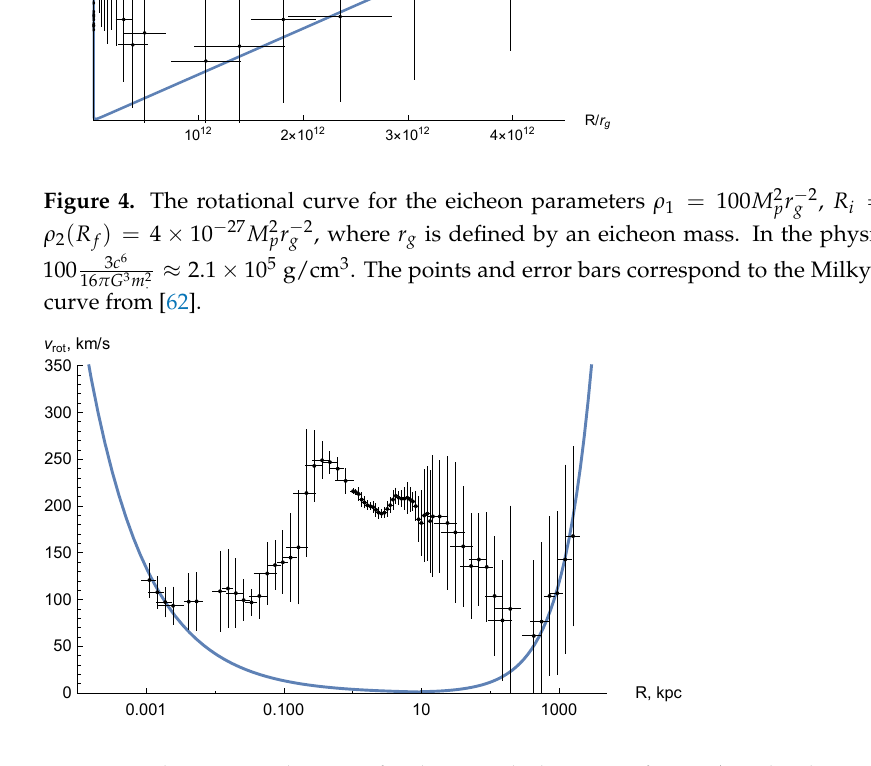
Figure 5. The rotational curve of eicheon with the mass of Sgr A ∗ with taking into account the vacuum polarization of F -type. The logarithmic scale is used and the points correspond to the Milky Way rotational curve from [62]. The eicheon parameters are given in the caption to Figure